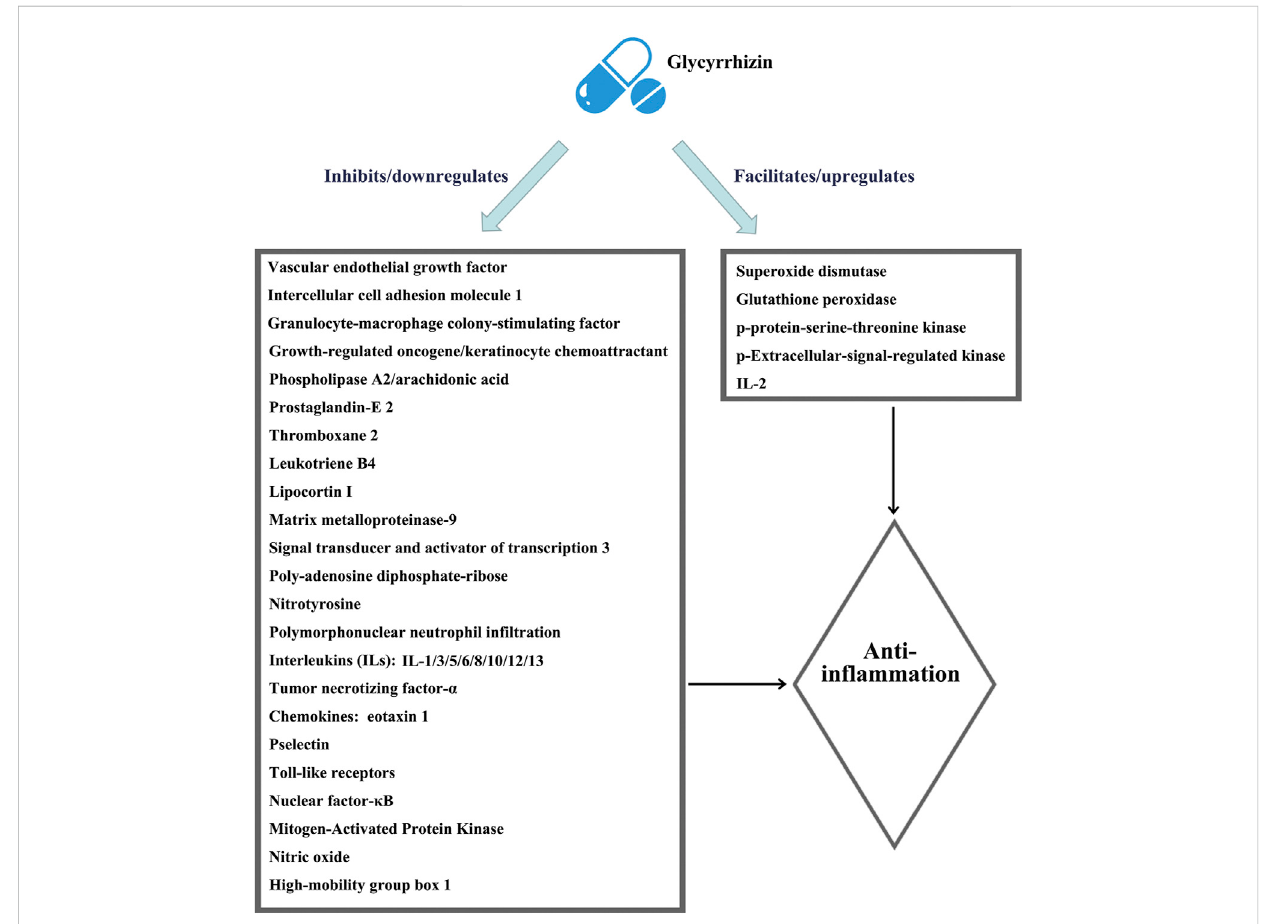
FIGURE 1 Schematicillustrationofthe comprehensive anti-in fl ammatory mechanisms ofglycyrrhizin. The fi gureisdrawn based onFigure 1 of Richard (2021).